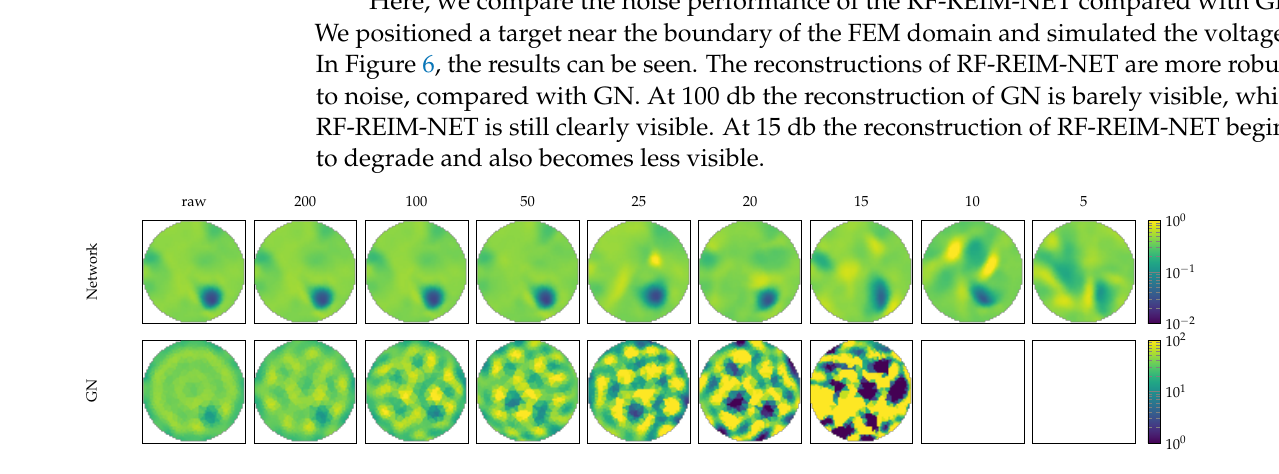
Figure 6. Evaluation of the noise performance of RF-REIM-NET ( top ) compared with GN ( bottom ). The columns represent different noise levels added with the EIDORS function add_noise . The target position is equal to T6 in Figure 4.